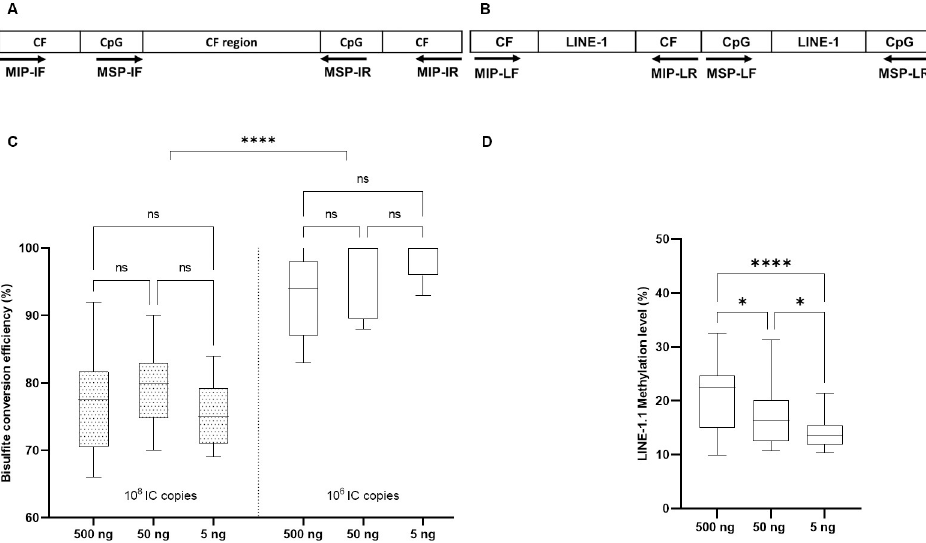
Fig 1. Impact of input genomic DNA quantity on bisulfite conversion efficiency and methylation level. After bisulfite treatment, (A) the internal control (IC) used to monitor bisulfite conversion efficiency, and (B) the LINE-1 . 1 sequence was amplified thanks to either the MIP primers targeting cytosine free sequences (CF) or the MSP primers targeting CpG sequences, respectively. Bisulfite conversion efficiency of the IC determined from bisulfite-treated samples containing 10 6 (equivalent ~0.004 ng) or 10 8 (equivalent ~0.4 ng) IC copies mixed with 500 ng, 50 ng or 5 ng of genomic DNA (C). The comparison in each group (10 6 or 10 8 copies) and between two group were done by mixed- effects analysis. LINE-1 . 1 methylation level calculated from bisulfite-treated samples containing 500 ng, 50 ng or 5 ng of genomic DNA mixed with 10 6 IC copies (D). One-way ANOVA were used to analyze the data in this experiment.